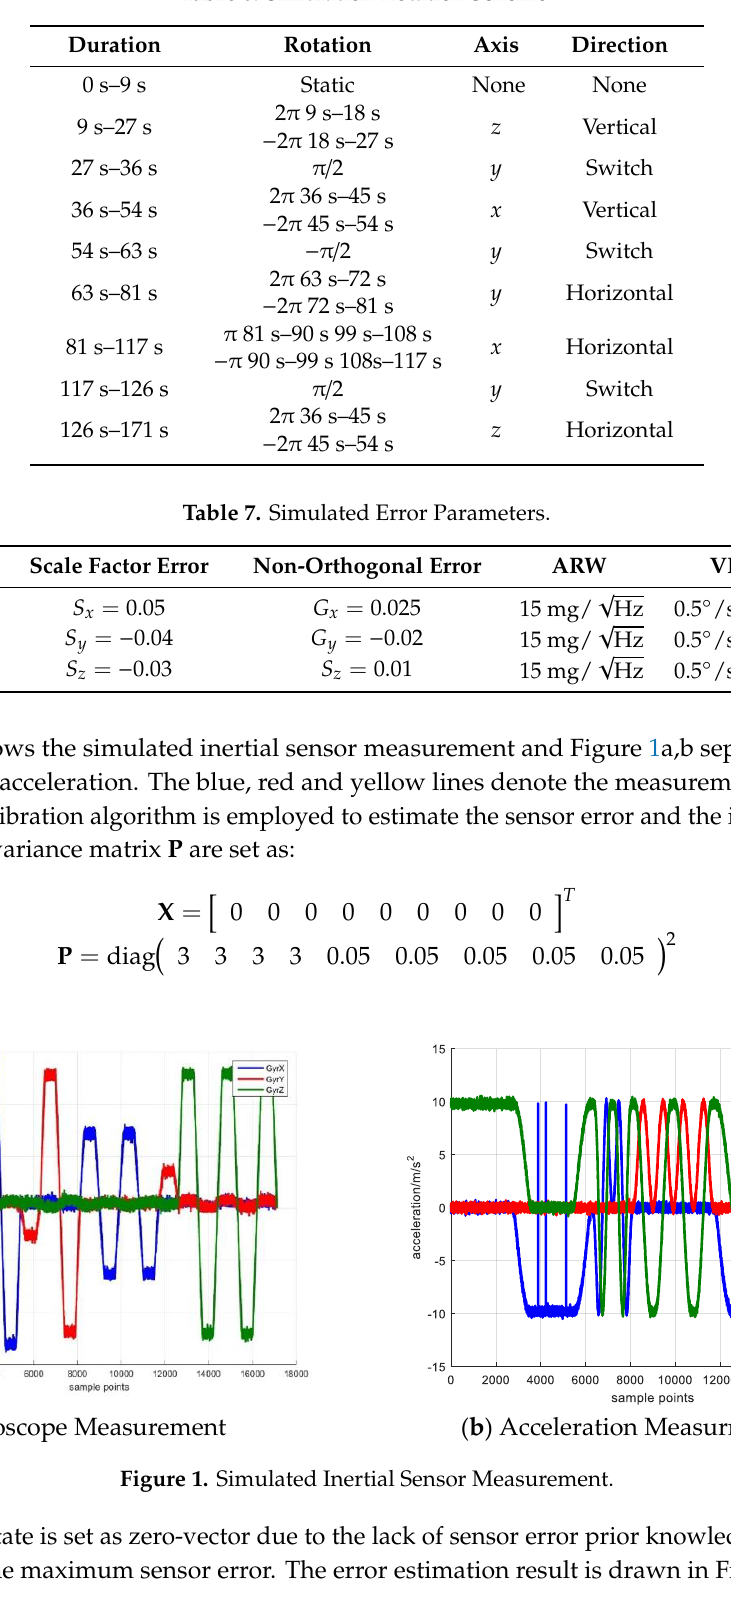
Table 6. Simulation Rotation Scheme.